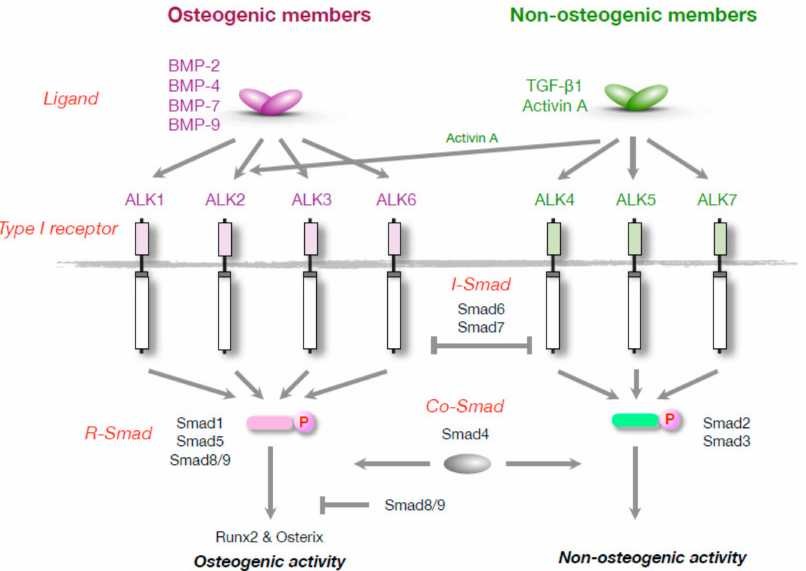
Figure 1. Schematic representation of signal transduction by osteogenic and non-osteogenic members of the transforming growth factor- β (TGF- β )